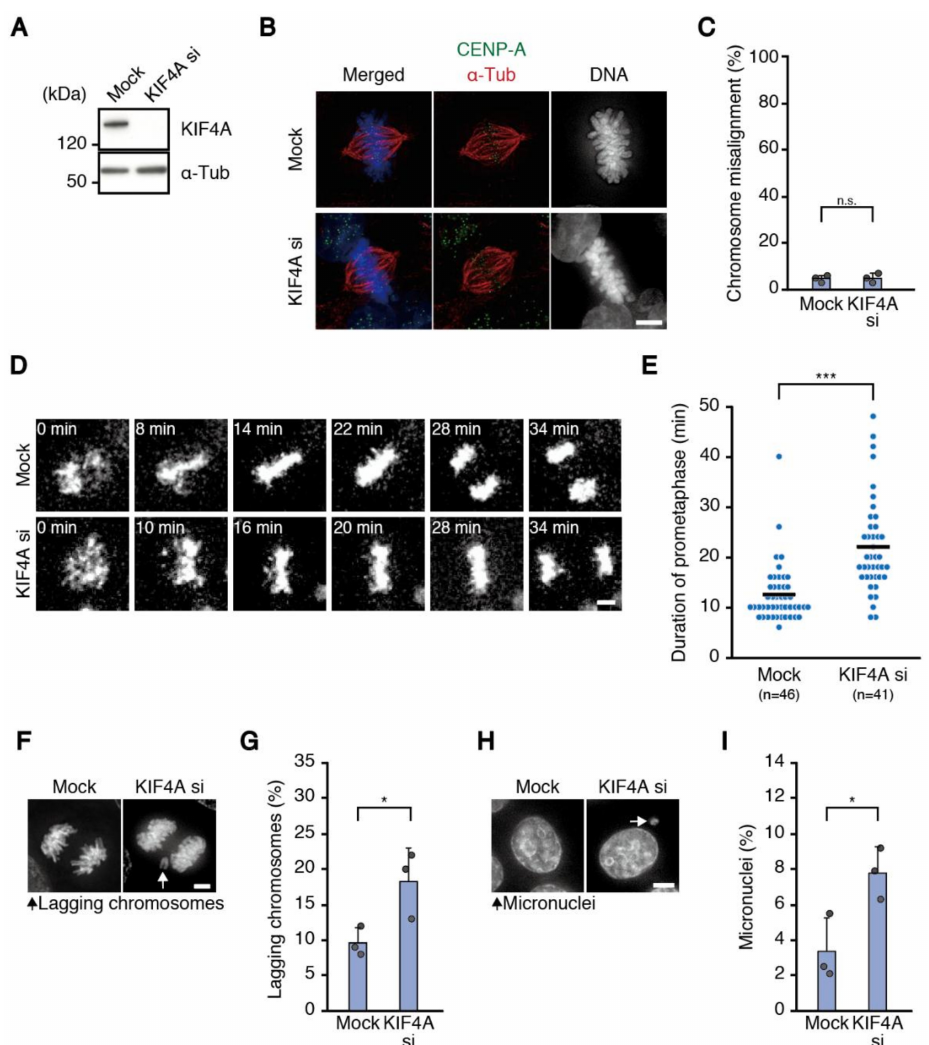
Figure 3. Cells depleted of KIF4A show delayed chromosome alignment and increased chromosome missegregation. ( A ) Efficiency of RNAi for KIF4A in HCT116 cells. Lysate of cells transfected with an siRNA against KIF4A was subjected to immunoblot analysis using antibodies as indicated; ( B ) chromosome alignment in cells depleted of KIF4A. HCT116 cells were transfected with the siRNA against KIF4A shown in ( A ), fixed after 1 h treatment with MG132 and immunostained with an antibody against CENP-A (green) and α -tubulin (red). DNA was stained with DAPI (blue). Scale bar: 5 µ m; ( C ) proportion of cells with misaligned chromosomes. HCT116 cells treated as in ( B )